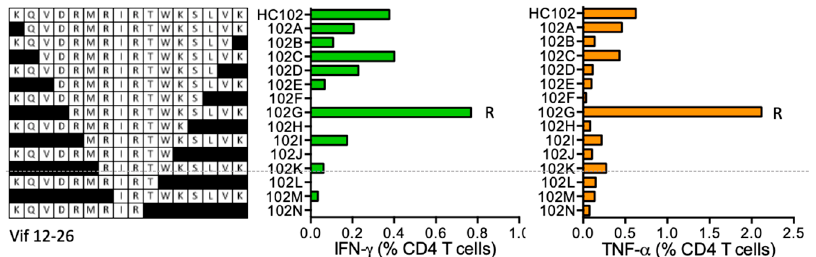
Figure 11. HC102 / VID 403—definition of CD4 + T-cell epitopes in HIV-1 protein Vif. HC102 peptide-expanded SCTL from volunteer 403 were stimulated in an ICS assay using truncated peptides (left) and CD4 + T cells producing IFN- γ (green) and TNF- α (orange) were enumerated using flow cytometry. Amino acid R indicates the stimulatory peptide termini.